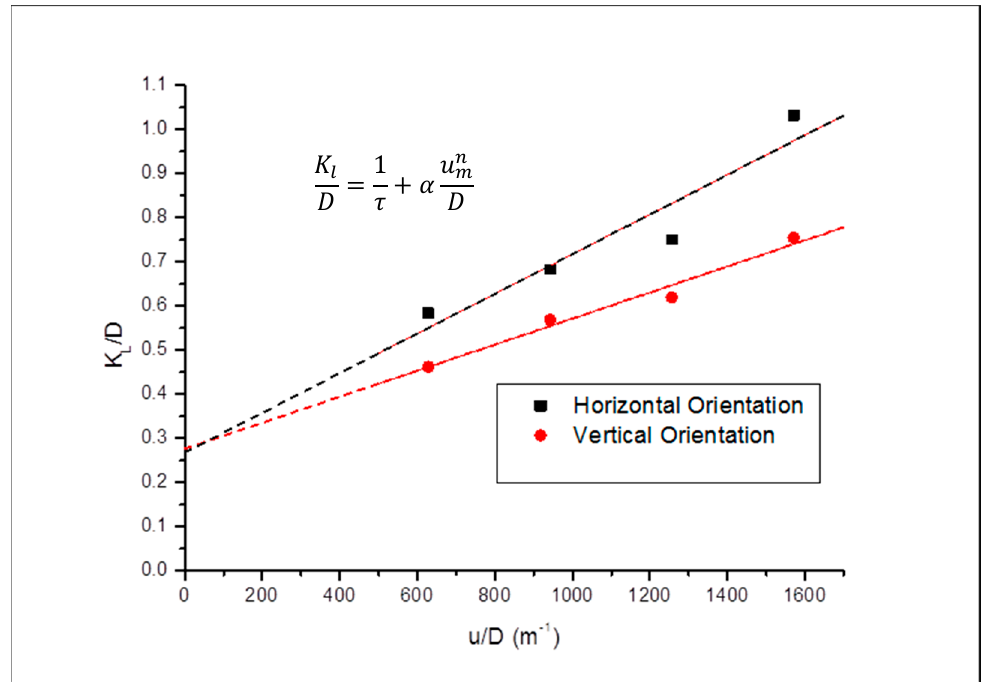
Figure 11. Comparison of the dispersivities in both orientations for Grey Berea.